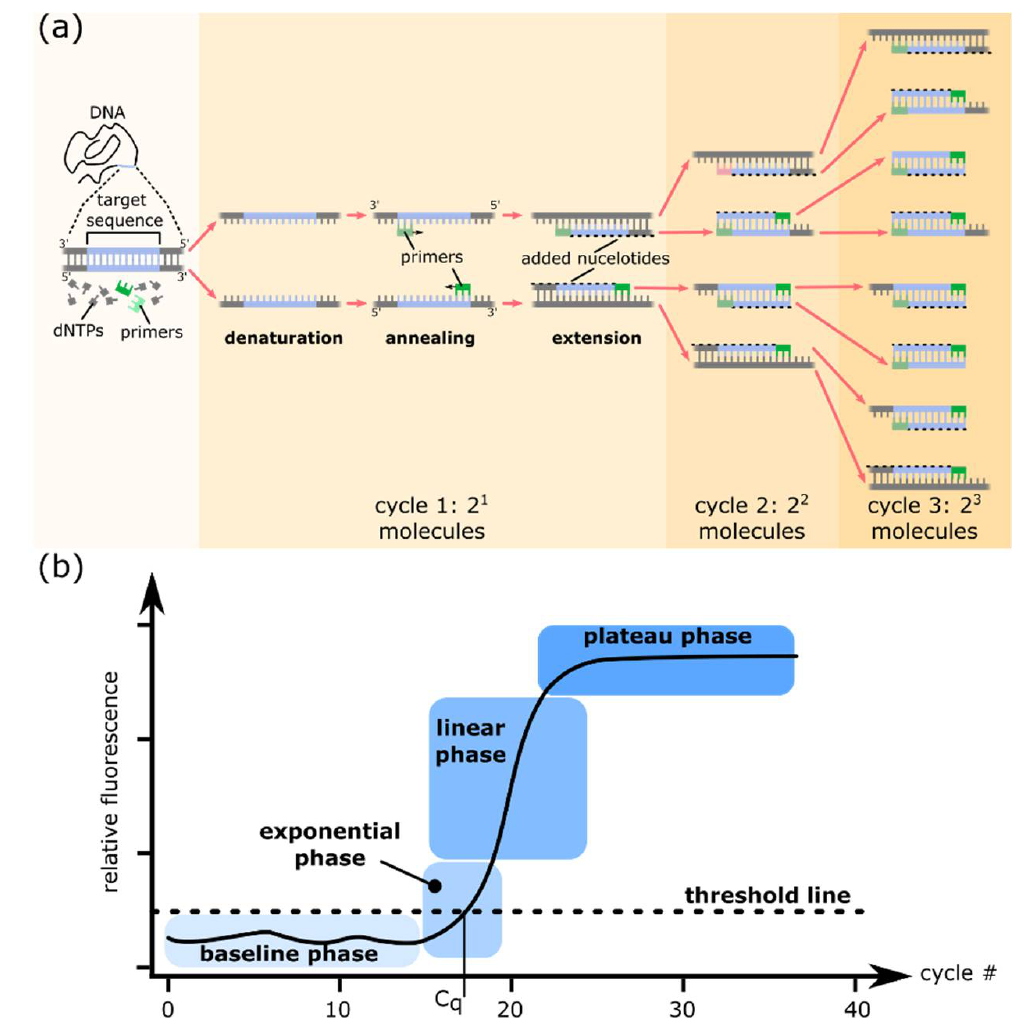
Figure 1. ( a ) Principles of the polymerase chain reaction (PCR). Each PCR cycle includes three steps: (1) Denaturation of double-stranded DNA by heat; (2) Annealing of primers to their complementary target DNA sequences; (3) Extension of primers by a thermostable DNA polymerase. A typical PCR